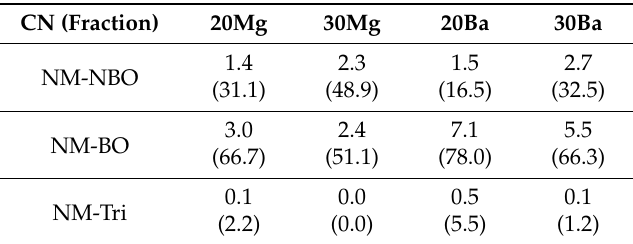
Table 4. Separation of NM-O coordination numbers (CN) of network-modifier ions (NM) into nonbridging oxygen (NBO), bridging oxygen (BO), and tricluster oxygen ions (Tri). Fractions [%] are given in